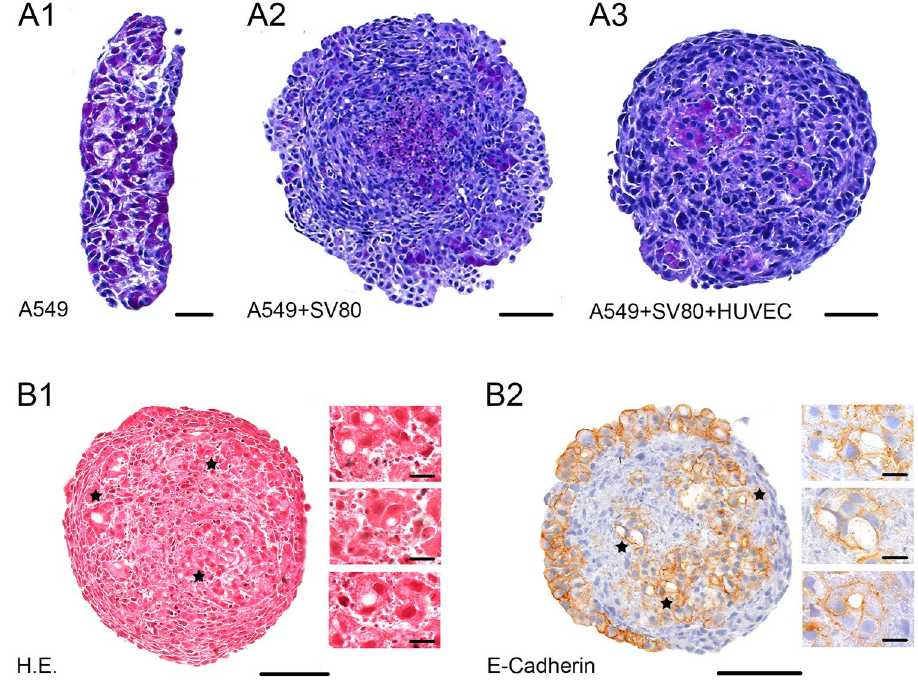
Figure 6. Glycoprotein expression and morphologic alteration of cancer cells. A1–A3: Periodic acid Schiff stain (PAS) positive cells increased in tri-cultures. Bar: 50 µ m. B1 + B2: Furthermore, A549 cancer cells started to resemble so-called signet ring cells. Asteriks indicates the localization of the insert. Bar: 100 µ m, Inserts 15 µ m.